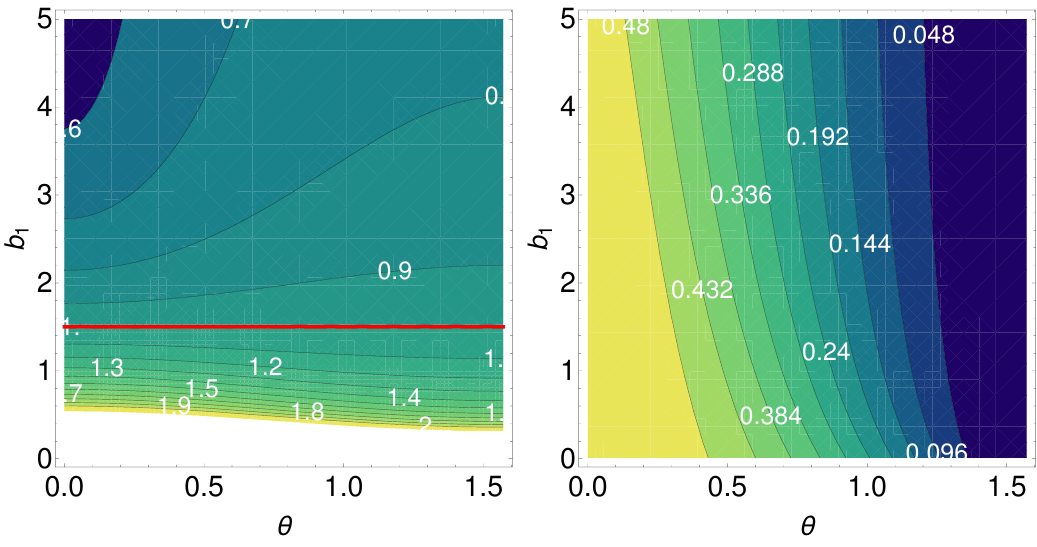
Figure 2 . (Color online) Contour plot showing various causal regions, obtained from eq. (4.36), for fast (left panel) and slow (right panel) branches. The red contour is the critical line of causality, denoting v 2 = 1. The region above the red line is causal for the fast magneto-sonic waves and L acausal below. The slow branch is causal throughout the parameter space. The magnitude of the magnetic (cid:12)eld has been (cid:12)xed to qB = 10 m 2 and the other parameters used are (cid:11) = 1 = 3, (cid:25) T = 200